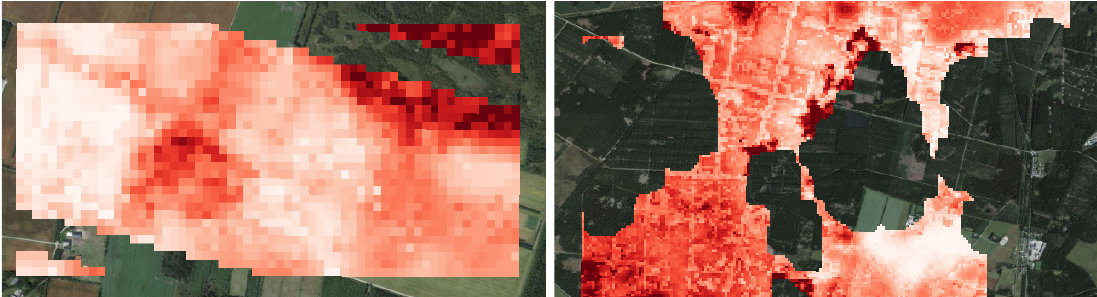
Figure 6. Two examples of gaps present in the disaggregated high-resolution flux estimates. On the left stripped gaps at VOU due to the failure of the sensor on board Landsat 7 and on the right gaps at GLU due to clouds during Landsat overpass. The darker reds indicate higher sensible heat fluxes. Even though small-scale flux variations due to features such as roads or fields are properly modelled, the total heat flux within a MODIS pixel might be biased due to the